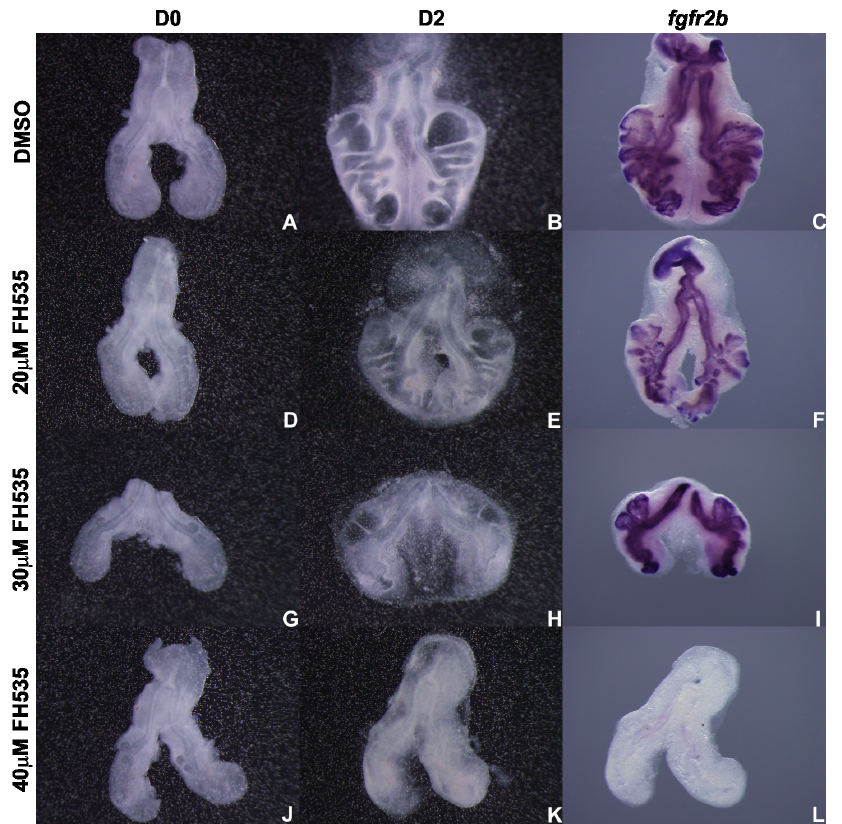
Figure 11. In vitro Wnt signaling inhibition and fgfr2b expression. Representative examples of stage b2 lung explant culture, at D0:0h (A, D, G, J) and D2:48h (B, E, H, K) treated with DMSO (A, B), 20 m M (D, E), 30 m M (G, H) and 40 m M FH535 (J, K) and probed with fgfr2b (C, F, I, L); n 5 4 for each stage. Magnification: A, B, D, E, G, H, J, K –4x; C, F, I, L